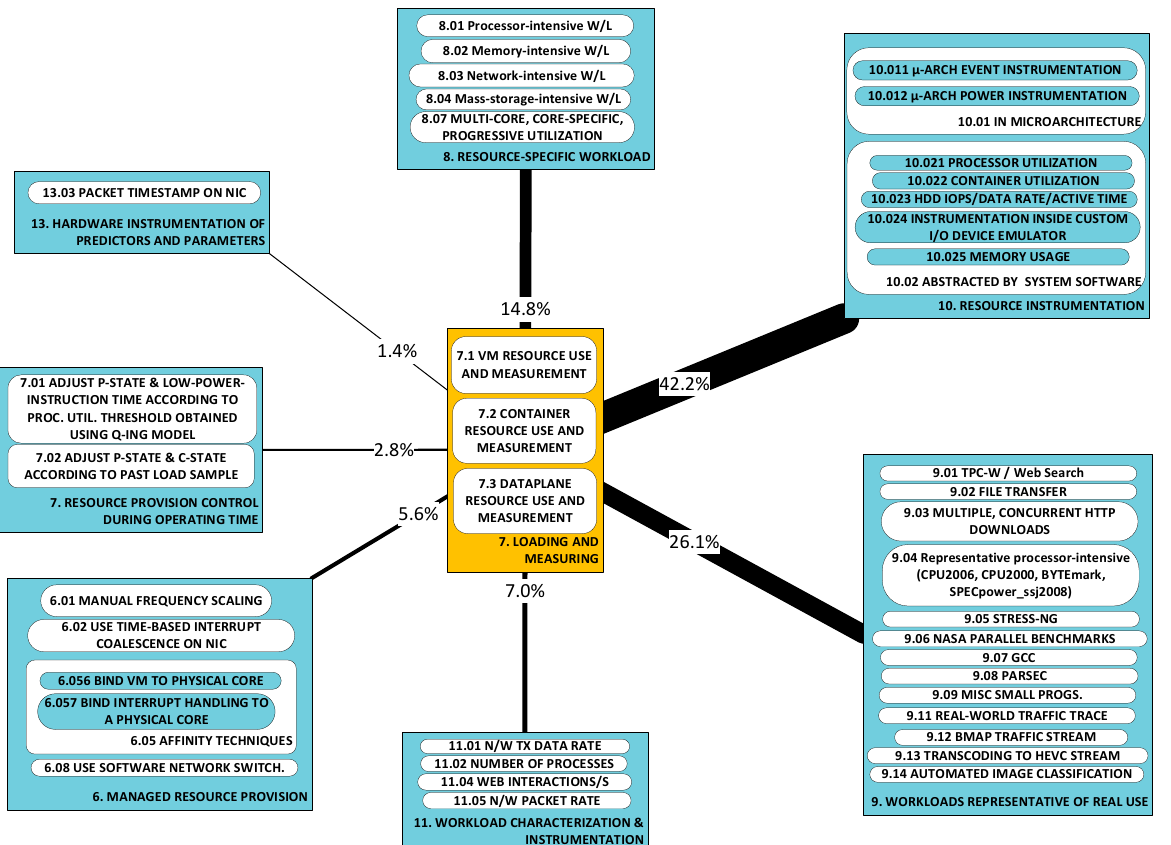
Figure 15. Approaches to solving challenges in category P7; utility metric U A (cid:2885) thickness and as a percentage. RUs in the respective categories are the following: P7 [56– 59,61,62,65,68,69,71,72,75–79,81–85,87]; A6 [56,68,81–83]; A8 [56,59,61,71,76,77,84,85]; A9 [56– 58,62,65,68,69,72,78,79,81–84,87]; A10 [56–59,61,62,69,72,75–79,81–85,87]; A11 [65,68,71,83,84,87]; A13 [87].